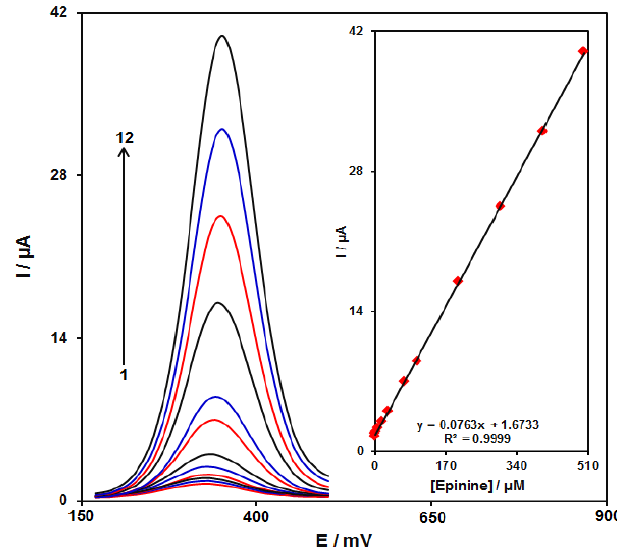
Figure 11. DPVs at the GO/ZIF-67/SPE in 0.1 M PBS (pH 7.0) containing different concentrations of epinine. Numbers 1–12 correspond to 0.09, 0.5, 2.5, 7,5, 15.0, 30.0, 70.0, 100.0, 200.0, 300.0, 400.0, and 500.0 μ M of epinine. The inset shows the plot of the peak current as a function of the epinine concentration in the range of 0.09–500.0 μ M.